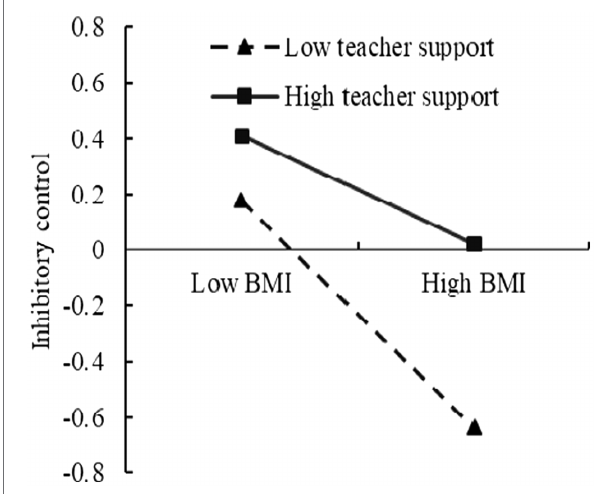
FIGURE 4 | The moderating effect of the teacher support on the relationship between BMI and inhibitory control.